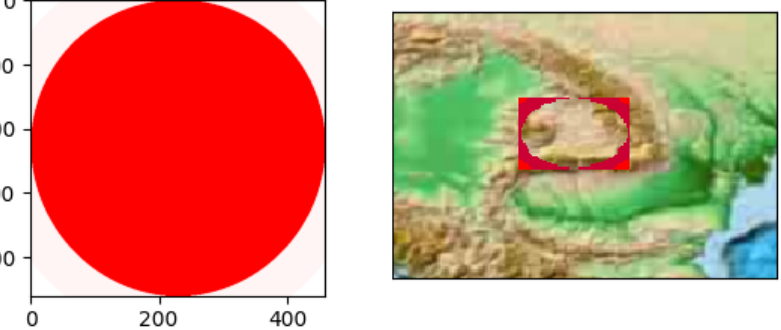
Figure 4. A visualization of the data points that are missing for all acquisitions at all elevation levels during an entire day in the NMA dataset for the reflectivity product. On the left, there is a visualization of the data matrix, in which each red pixel indicates that the value is present all day for all elevations. On the right, there is a visualization of the missing data projected onto the map, in which the red color indicates that the values are missing all day for all acquisitions at all elevation